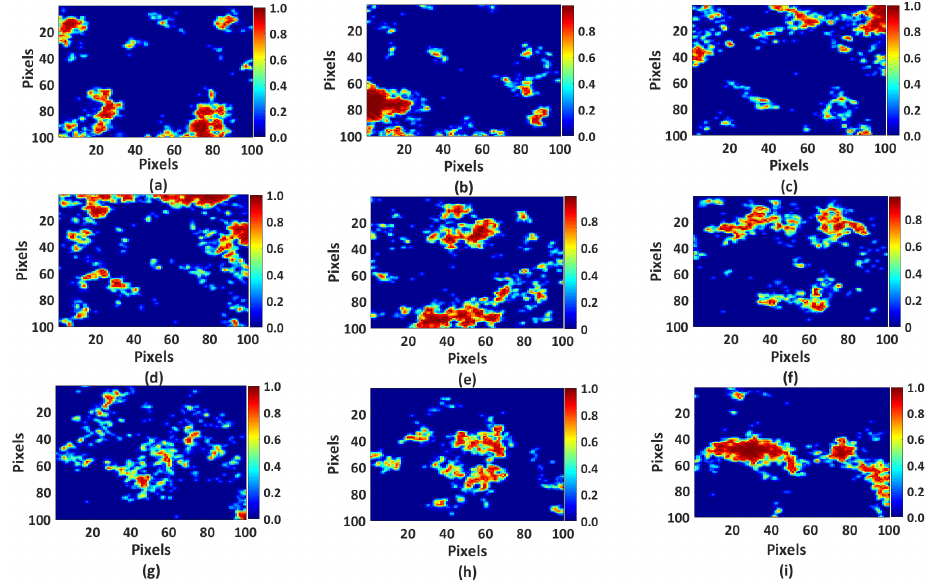
Figure 3. True fractional abundances of the endmembers in the synthetic vegetation image: ( a ) leather oak; ( b ) sandy loam; ( c ) concrete; ( d ) dry grass; ( e ) lime stone; ( f ) pine wood; ( g ) red brick; ( h ) terracotta tiles; and ( i ) tumble